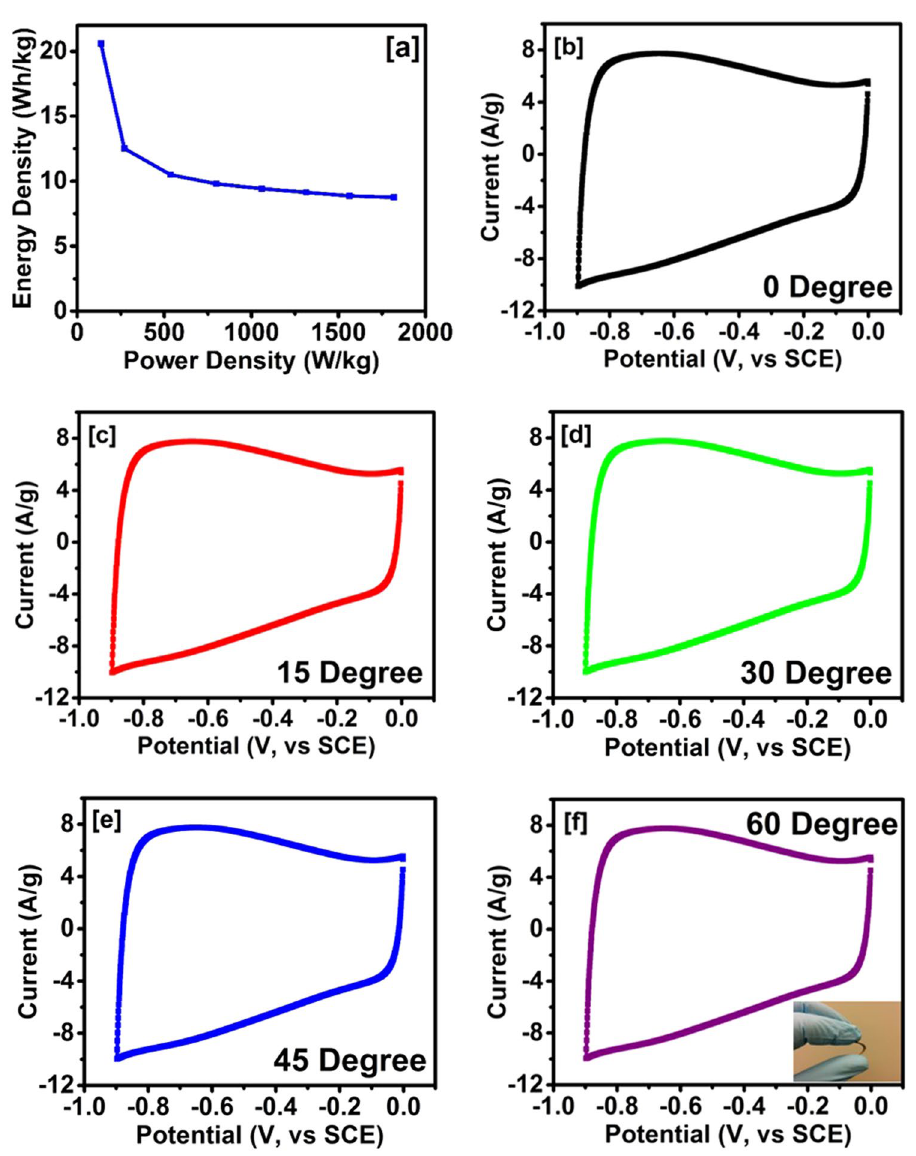
Figure 7. ( a ) Variation of power density versus energy density and ( b–f ) flexibility test of carbonized